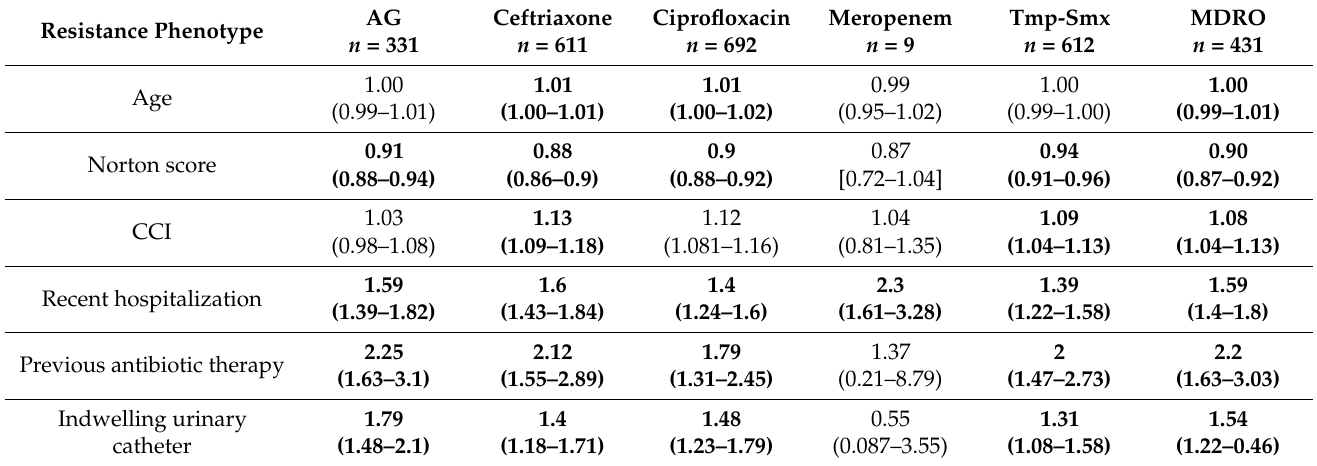
Table 2. Association between patient covariates and antibiotic resistance